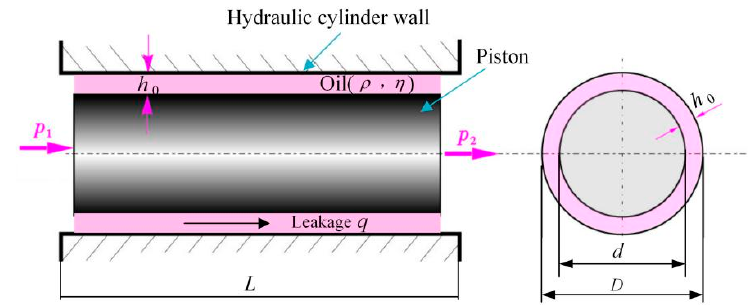
Figure 6. Schematic diagram of relevant parameters in leakage calculation .